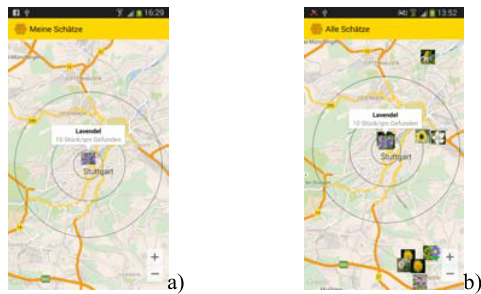
Figure 13: Localised bee-flowers. a) My treasures (Meine Schätze), b) All treasures (Alle Schätze) (Source: Shohrab Uddin).